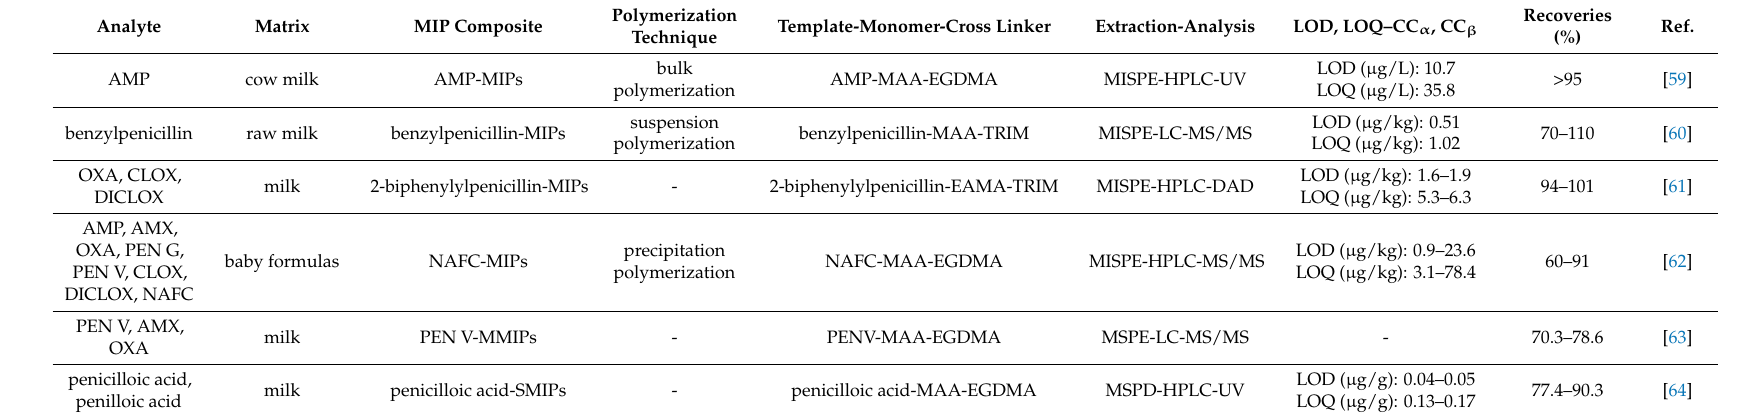
Table 2. MIPs applications for the determination of penicillins in milk